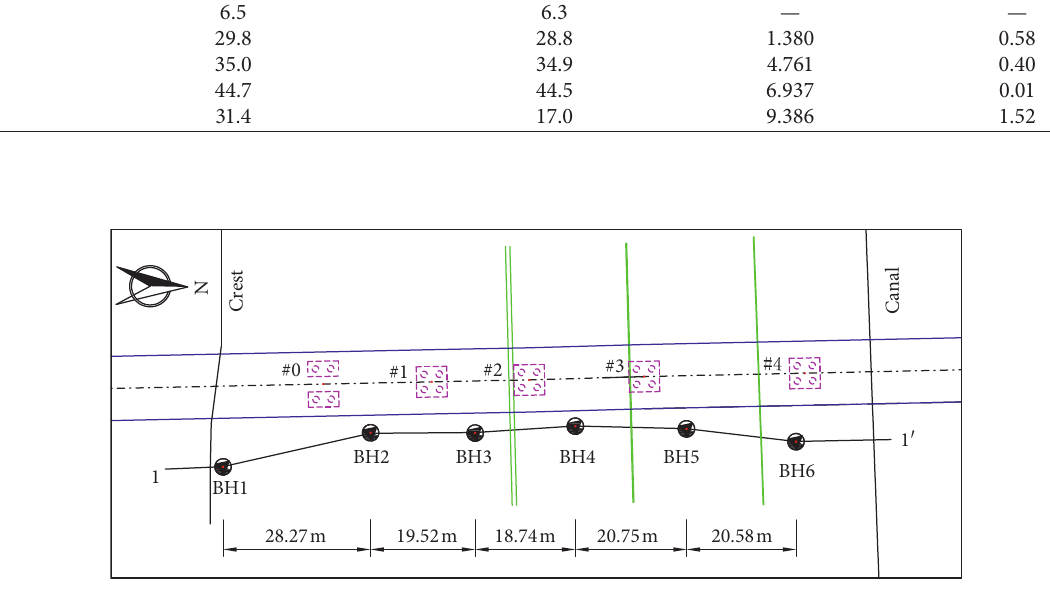
Figure 3: The layout of the soil